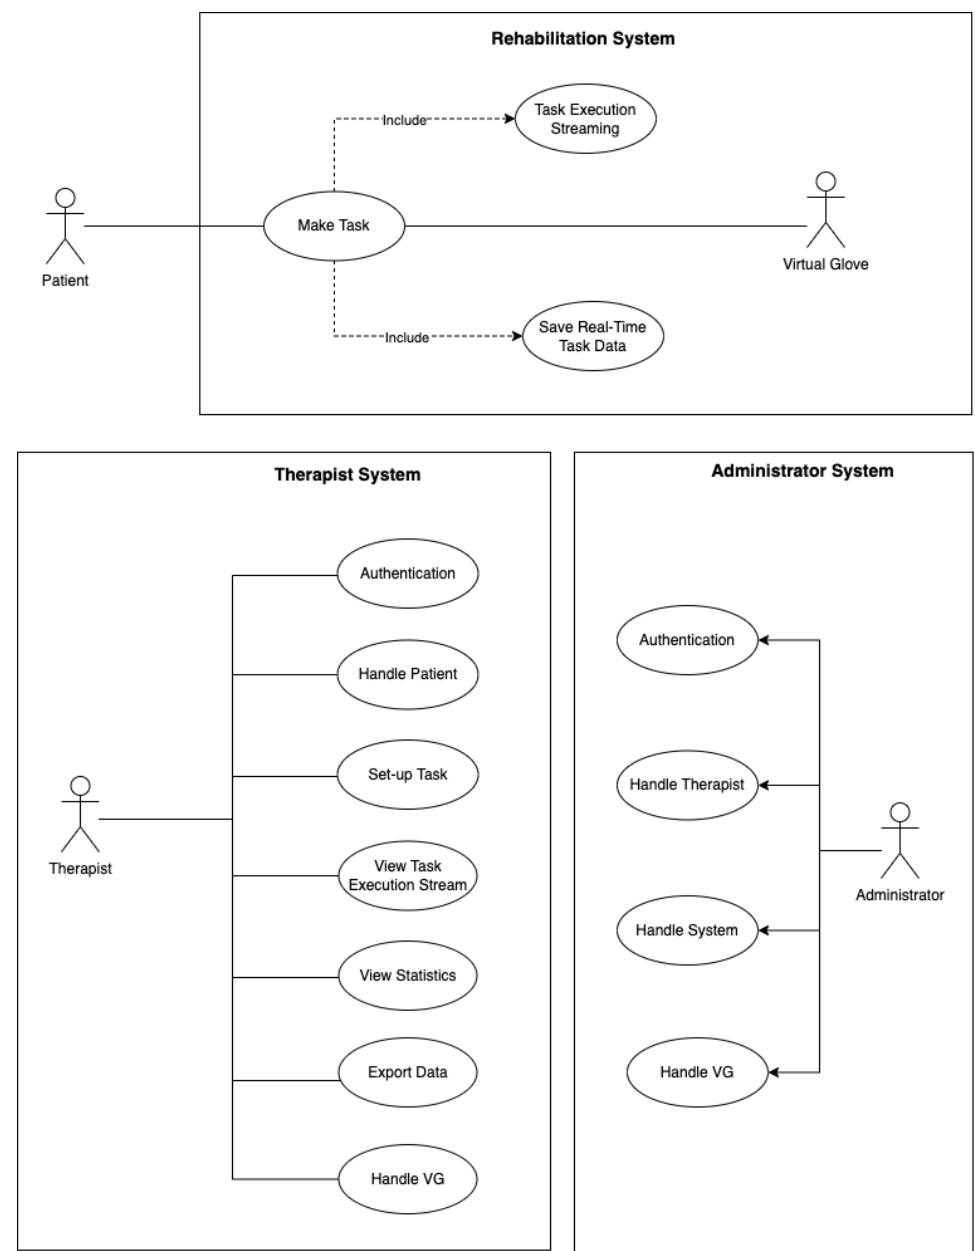
Figure 5. Use a case diagram presenting the functionalities and actors involved to the framework’s